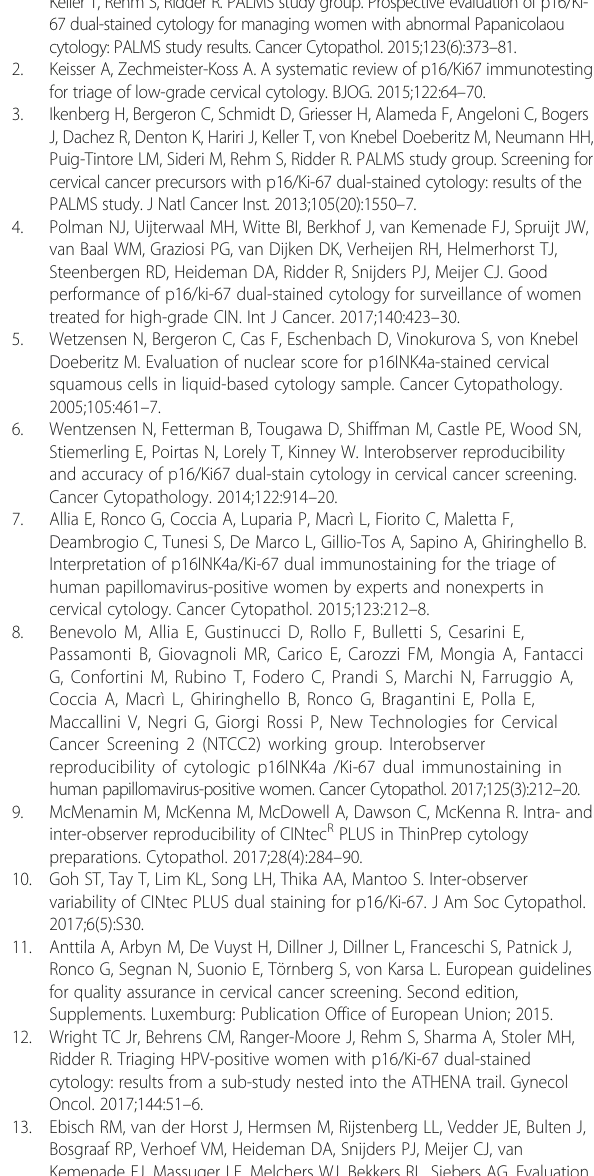
Additional file 1: Table S1. Individual comparison of p16/Ki-67 agreement and performance between cytoscreeners, cytopathologists and reference2, and between reference1 and reference2, before and after the additional training. Table S2. Sensitivity, specificity, negative and positive predictive value of p16/Ki-67 DS results for detecting CIN2+ in three cytopathology laboratories, for references1 and reference2 before and after the additional training. (DOCX 19